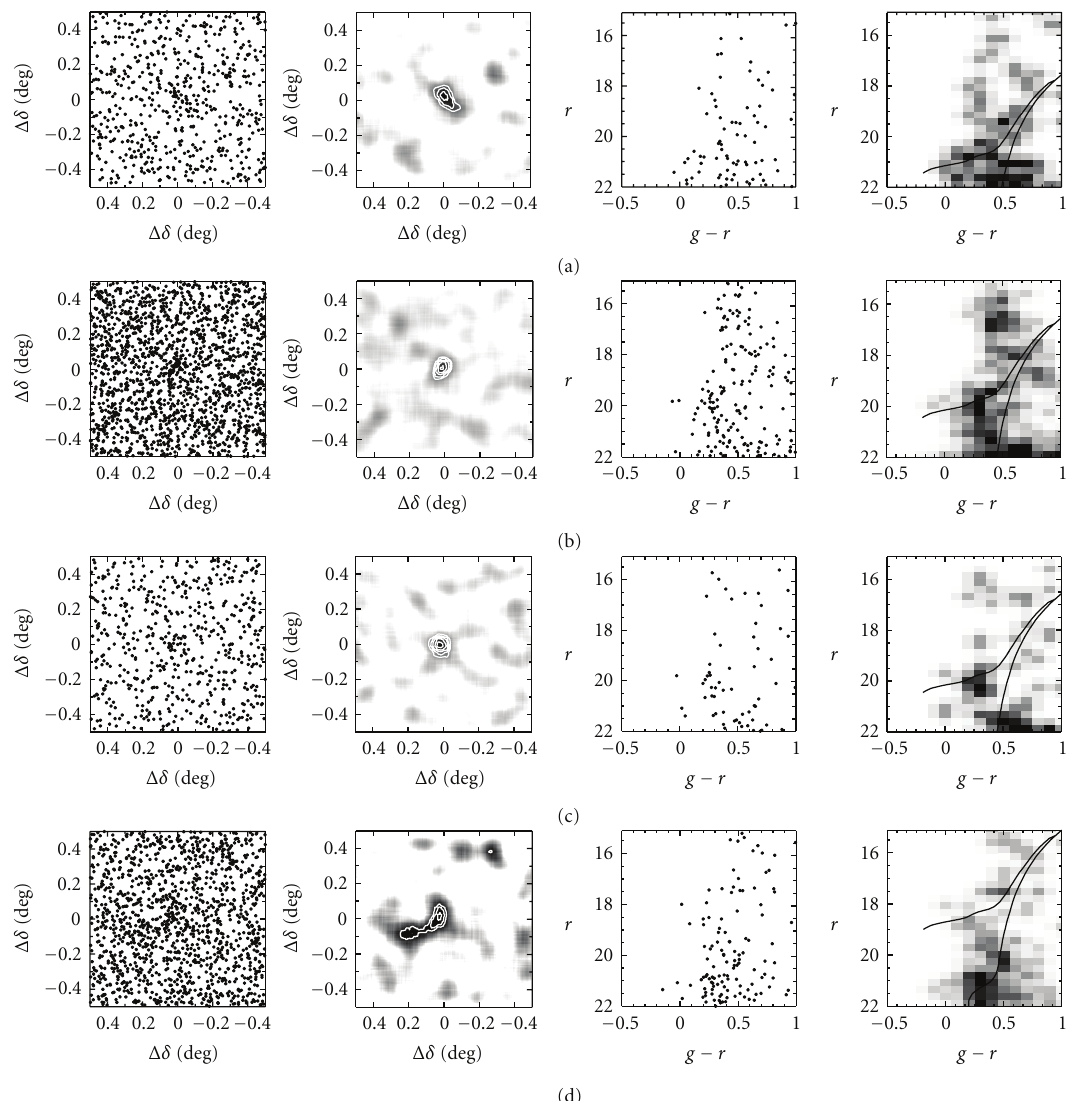
Figure 2: Four stellar overdensities found in SDSS-DR6 with detection significances equal to or greater than known MW satellites. Candidates were found (from top to bottom) in the constellations Canes Venatici, Hercules, Ursa Major, and Virgo. Isochrones in the Hess diagrams (right panel) show at what heliocentric distances those overdensities produced the strongest signal (figures from